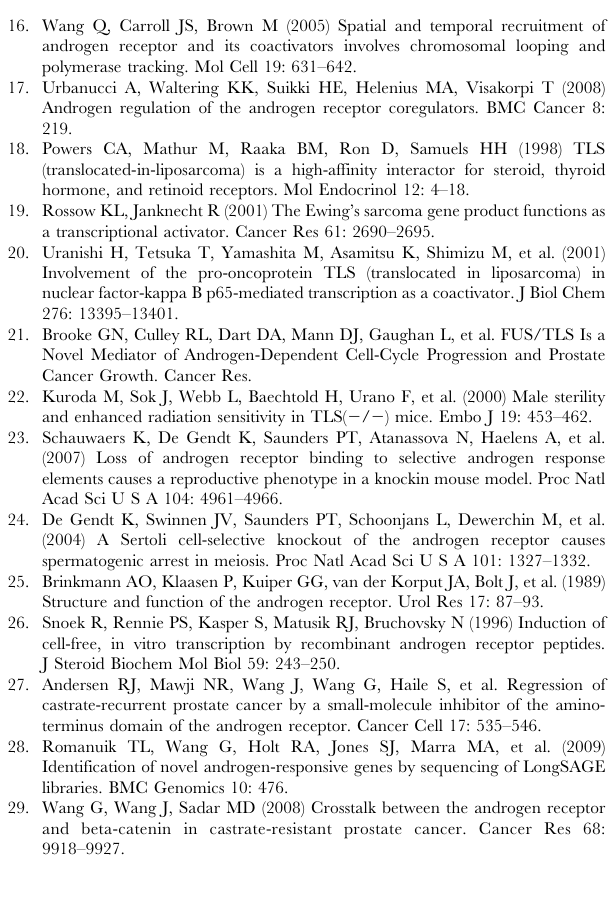
Figure S3 Comparative analysis of FUS expression in various cancer cells. Cell lines representing various cancer types were grown in their respective cell lines. Quantitative RT- PCR was performed to quantify FUS mRNA relative to GAPDH. LNCaP was used as reference for relative normalized expression. Prostate cancer cell lines that are AR positive are shown in red and in blue are AR negative prostate cancer cell lines. In black are non-prostatic cancer cell lines. Columns = mean 6 standard deviation. *P , 0.05, n= 3.